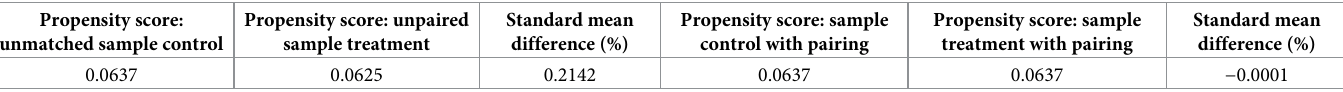
Table 4. Matching results by propensity score (PSM).